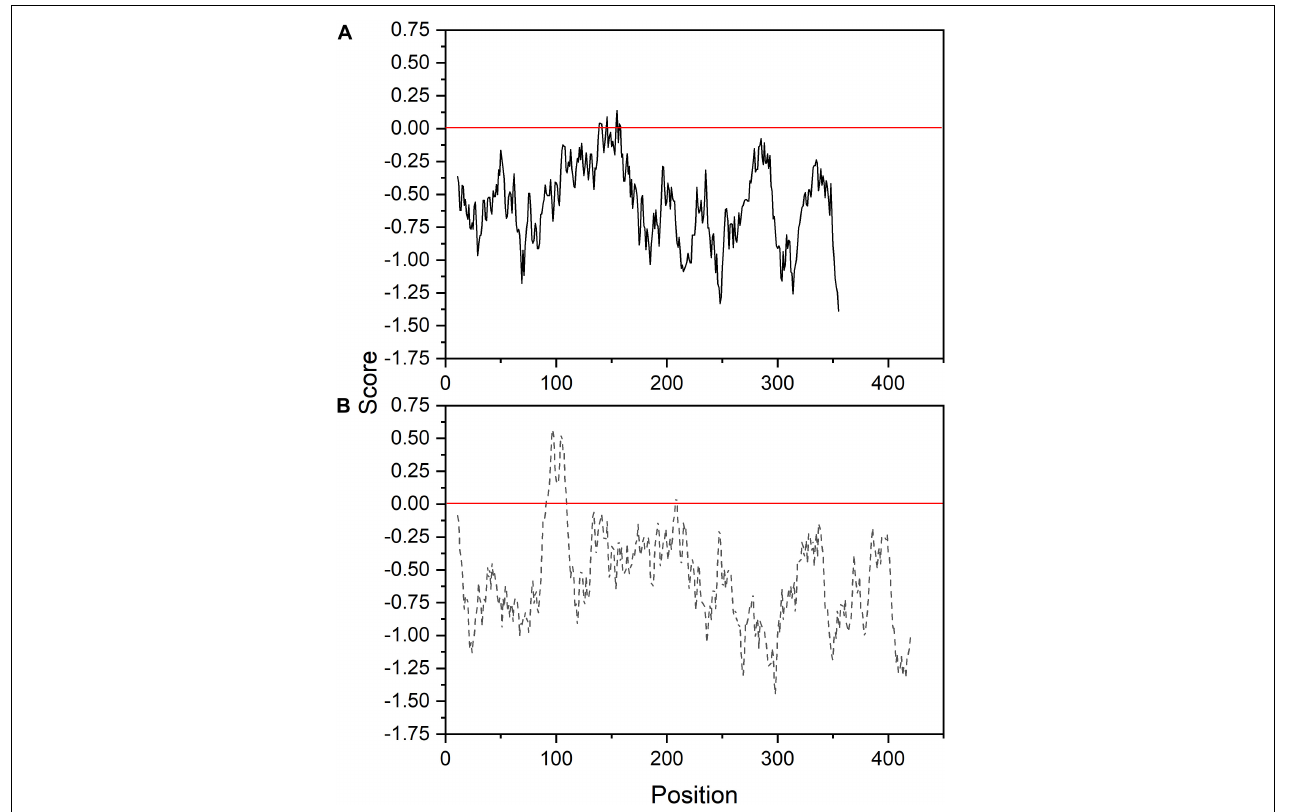
FIGURE 3 | Membrane tendency profile of sunflower FatA (A) and FatB (B)